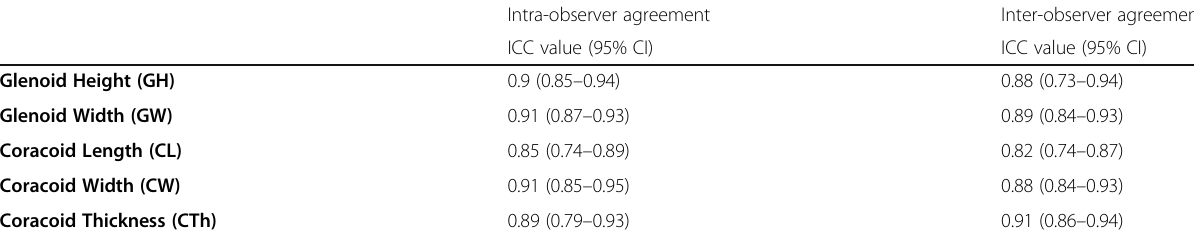
Table 1 Intra- and inter-observers agreements measured by the Intraclass Correlation Coefficient (ICC), 2 by 2 with 95% of confidence